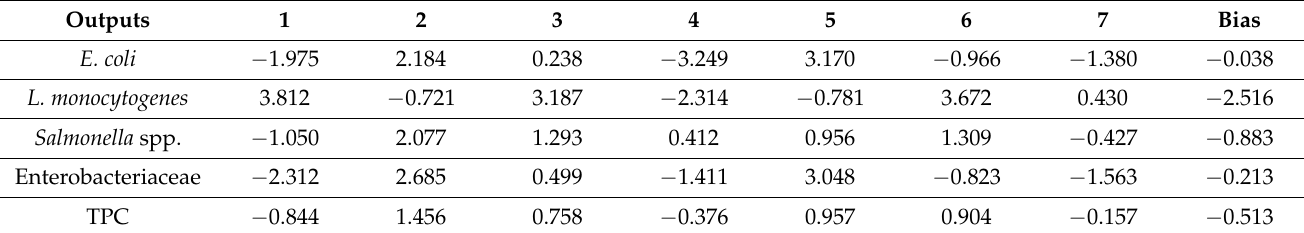
Table 7. The weight coefficients and biases: W 2 and B 2 , respectively.